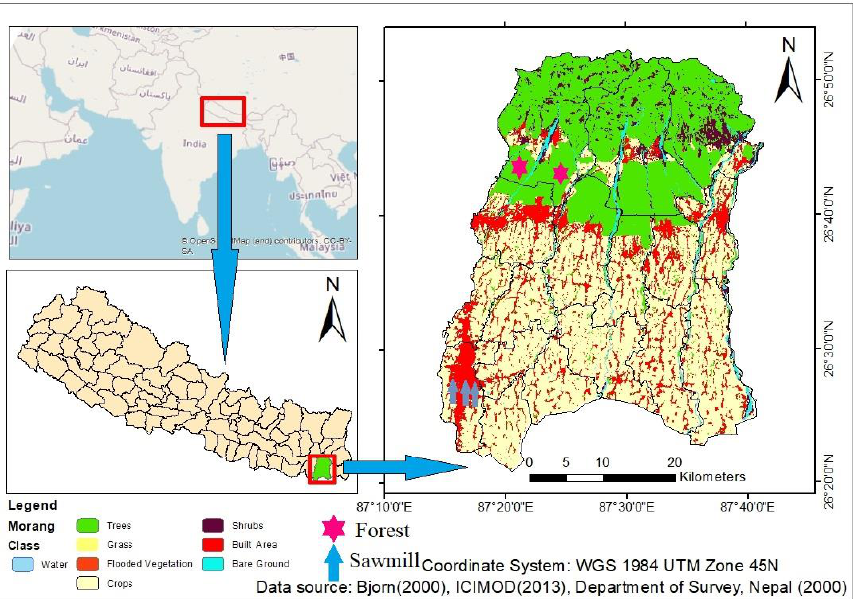
Figure 1. Map showing study area including the two sampled forests and three sampled sawmills.